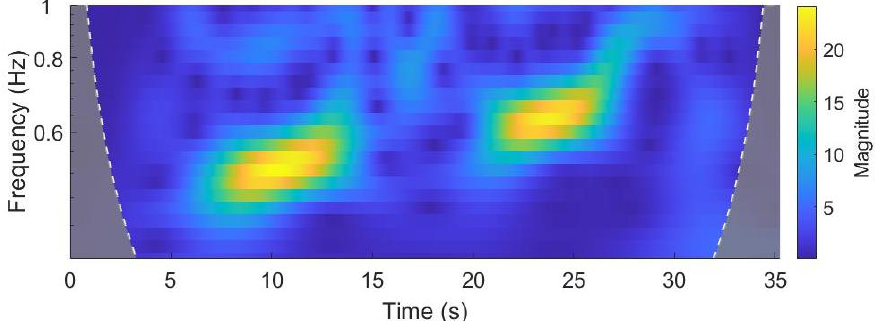
Figure 3. Absolute value of the CWT plotted as a function of time and frequency. Yellow zones represent the walking segments of the signal.